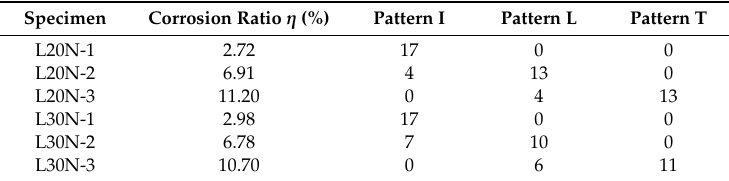
Table 5. The number of cracking patterns in each